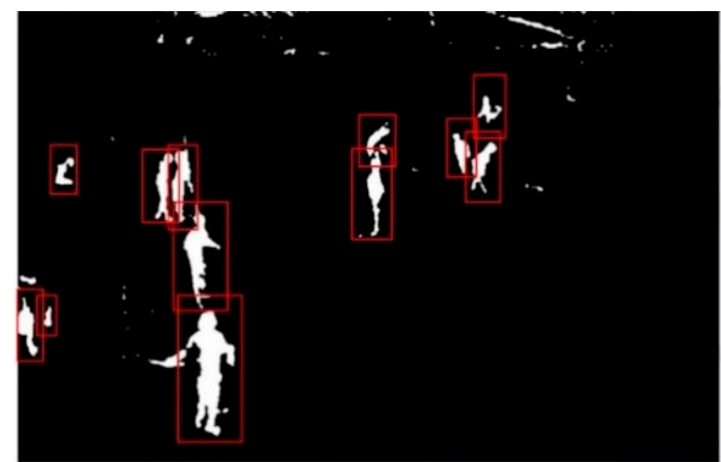
Figure 9. Windows of moving object identification.